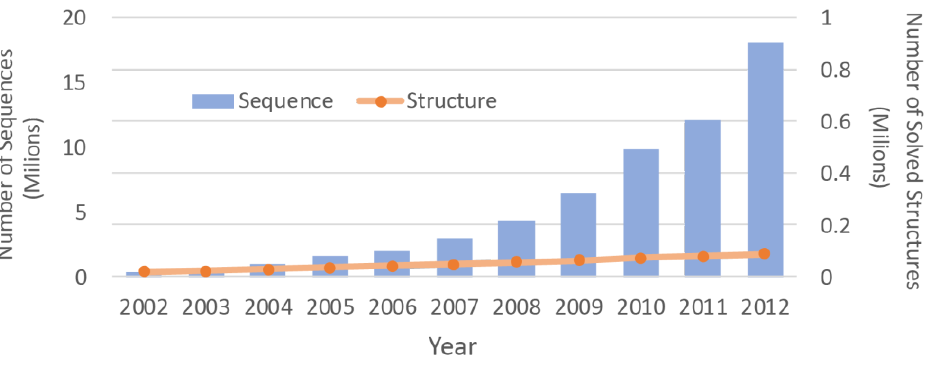
Figure 1. Number of solved structures versus number of identified protein sequences. Numbers of sequences and protein structures are obtained through Uniprot (http://www.ebi.ac.uk/uniprot/) and RCBS PDB (http://www.rcsb.org),